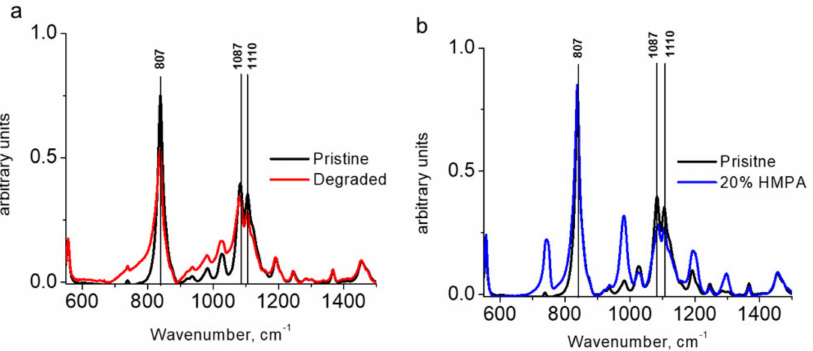
Figure 6. ( a ) FTIR spectra 1 M NaPF 6 in DME before and after decomposition at 85 ◦ C; ( b ) FTIR spectra of 1 m NaPF 6 in DME after exposure to 85 ◦ C (compared to pristine 1 m NaPF 6 in DME). Liquid-phase FTIR shows changes in peak intensity of the PF 6 P-F stretch (807 cm − 1 ).